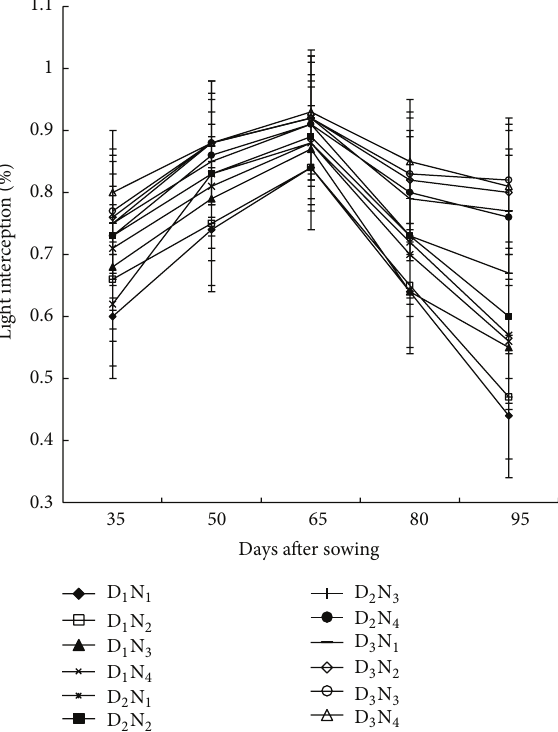
Figure 2: Leaf area index at different growth stages of maize as affected by planting density and N-fertilizer application (D 1 = 53,000 plant/ha, D 2 = 66,000 plant/ha, D 3 = 80,000 plant/ha, N 1 = 100kg N/ha, N 2 = 140kg/ha, N 3 = 180kg N/ha, N 4 = 220 kgN/ha. Bar showed ± SE value).